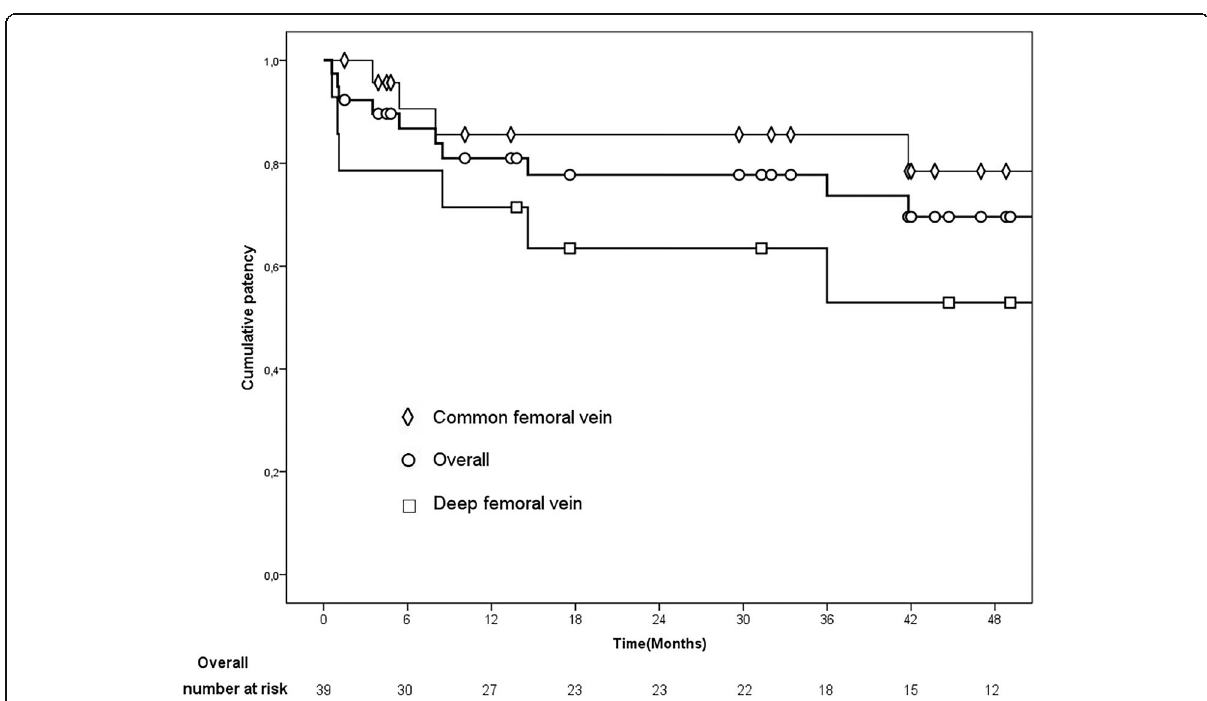
Fig. 4 Cumulative primary patency for stents extending into the common femoral vein ( ◊ ), overall ( ○ ), and deep femoral vein ( □ ),respectively